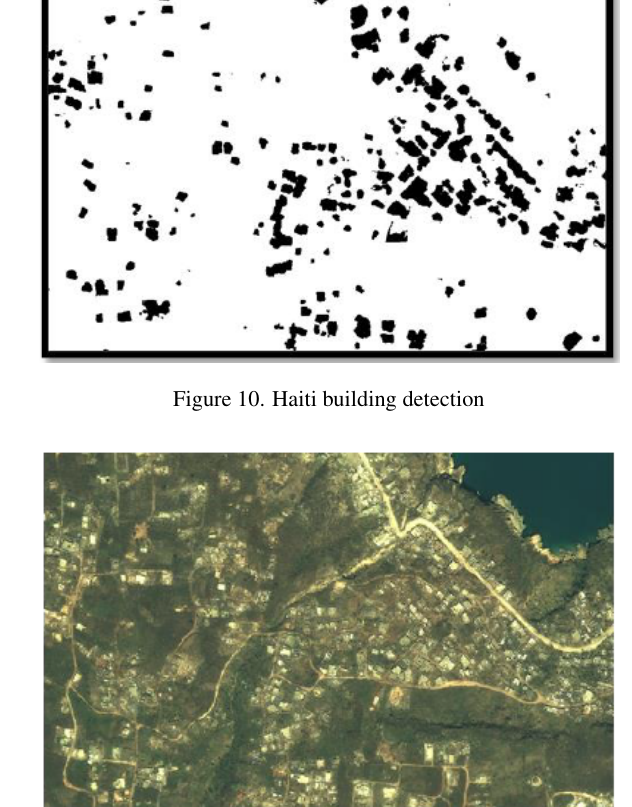
Table 5. Binary siamese networks results